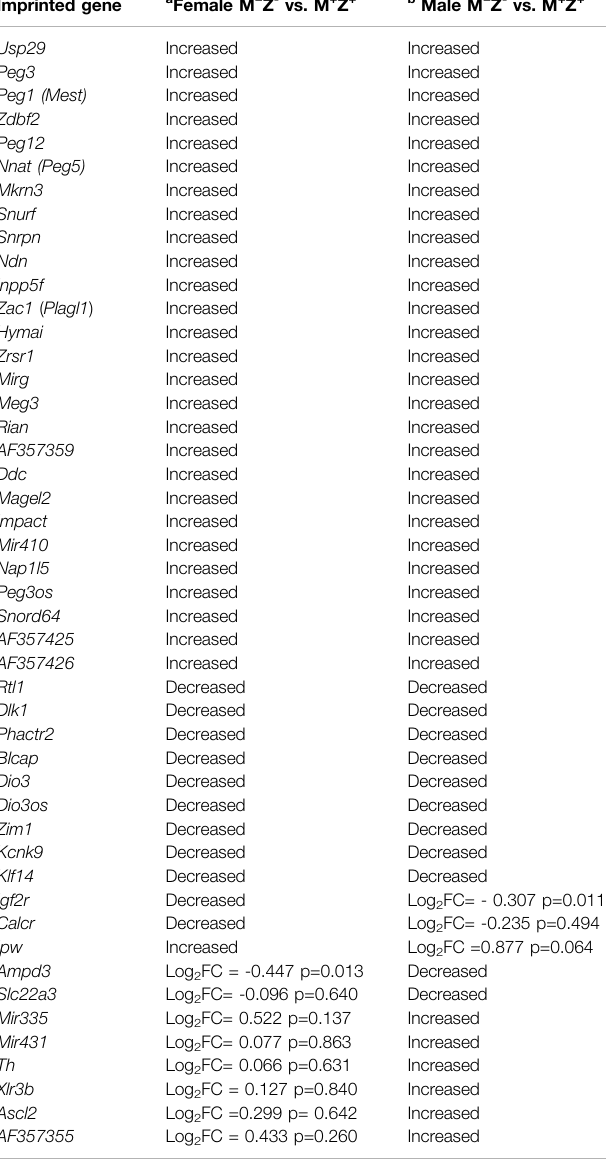
TABLE2| Expressionlevelsoftheseimprintedgenesweresigni fi cantlydifferentin either the female or male M − Z - embryos compared with the M + Z + embryos of the same gender. Imprinted